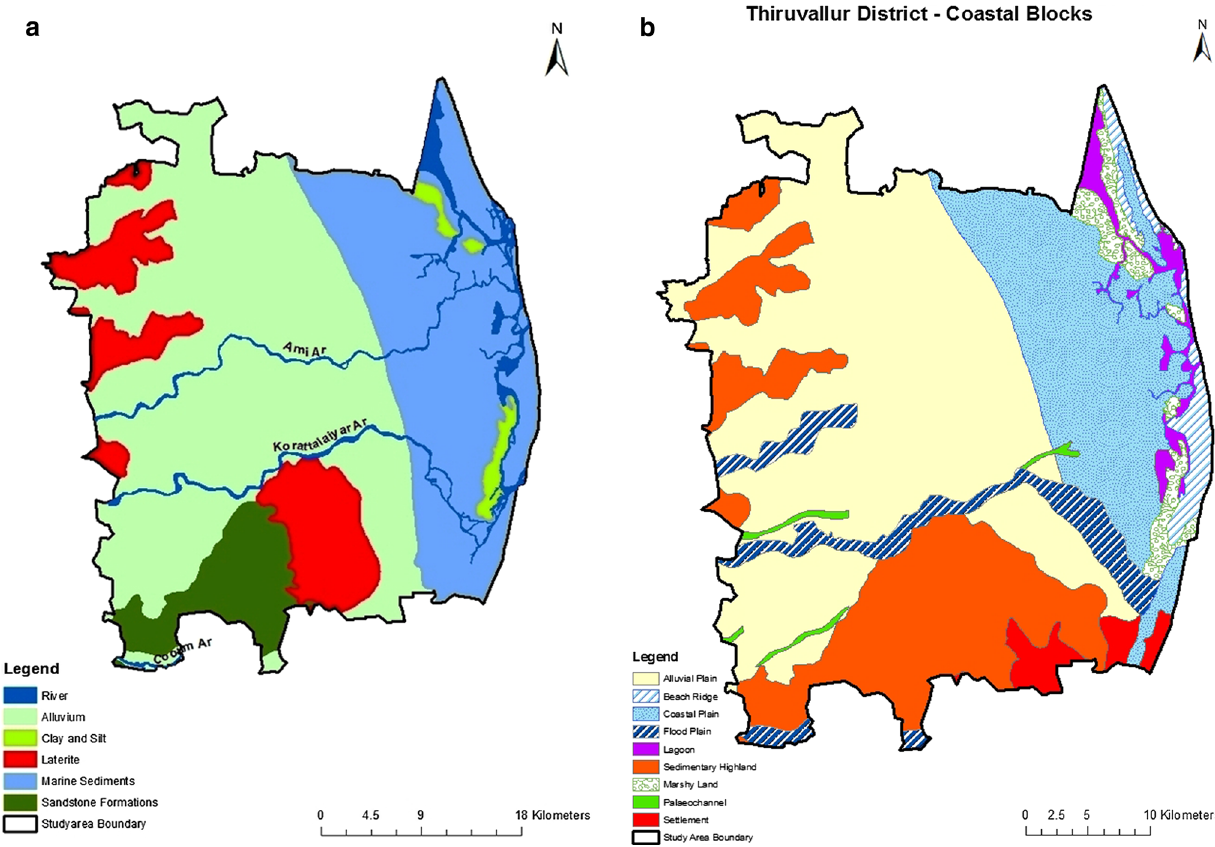
Fig. 2 a Geology map. b Geomorphology